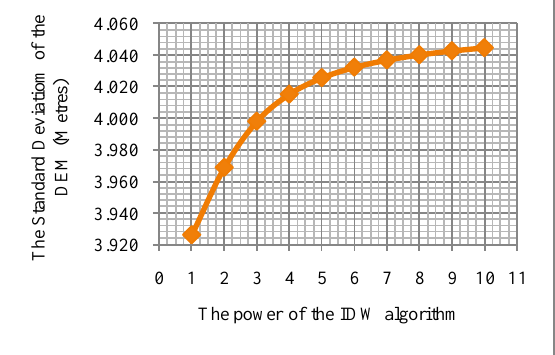
Figure 23: The effect of changing the power of the IDW on the standard deviation of the elevations in the generated